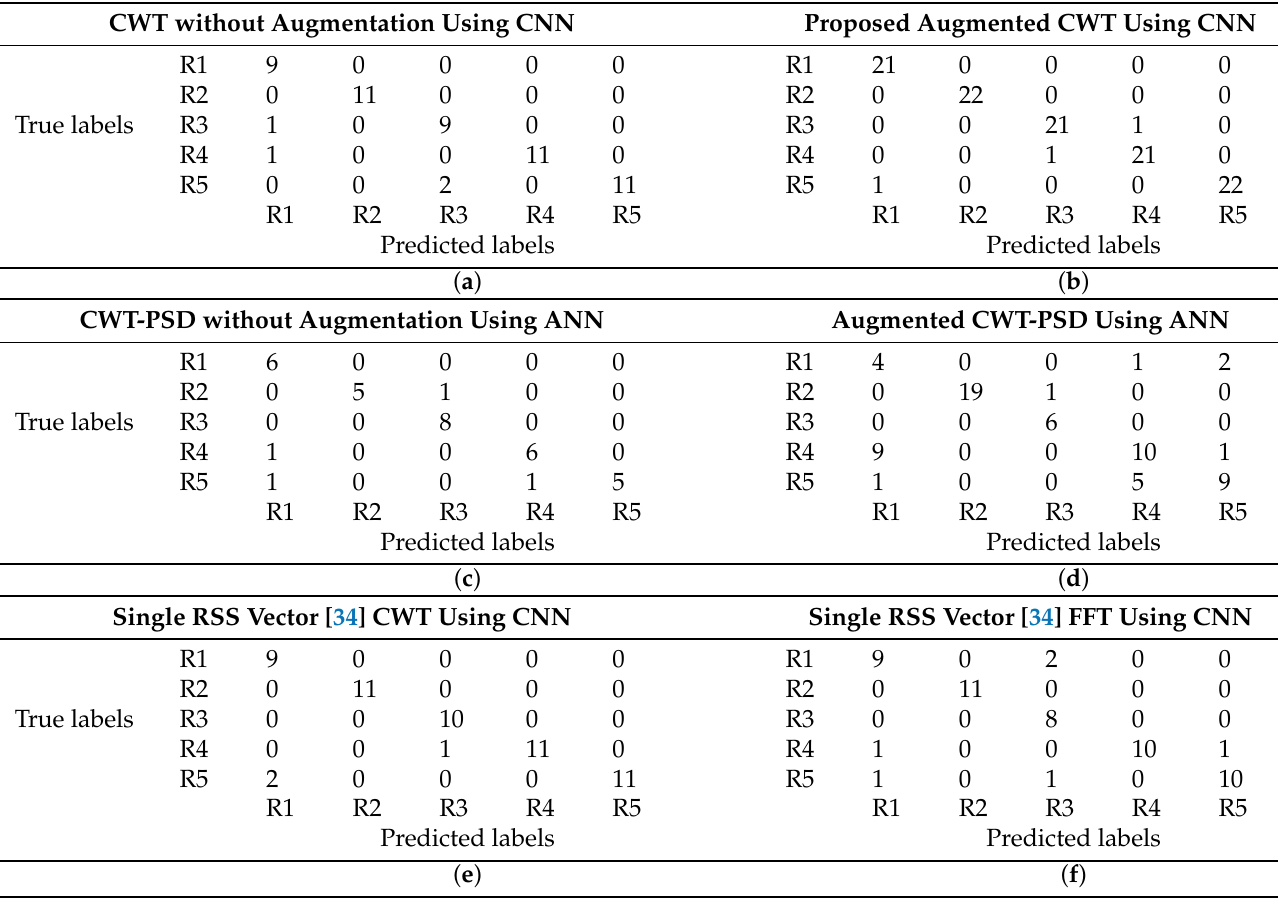
Table 6. Confusion matrices for room identification: ( a – e ) using the Morse mother wavelet, and ( f ) using FFT. CWT without Augmentation Using